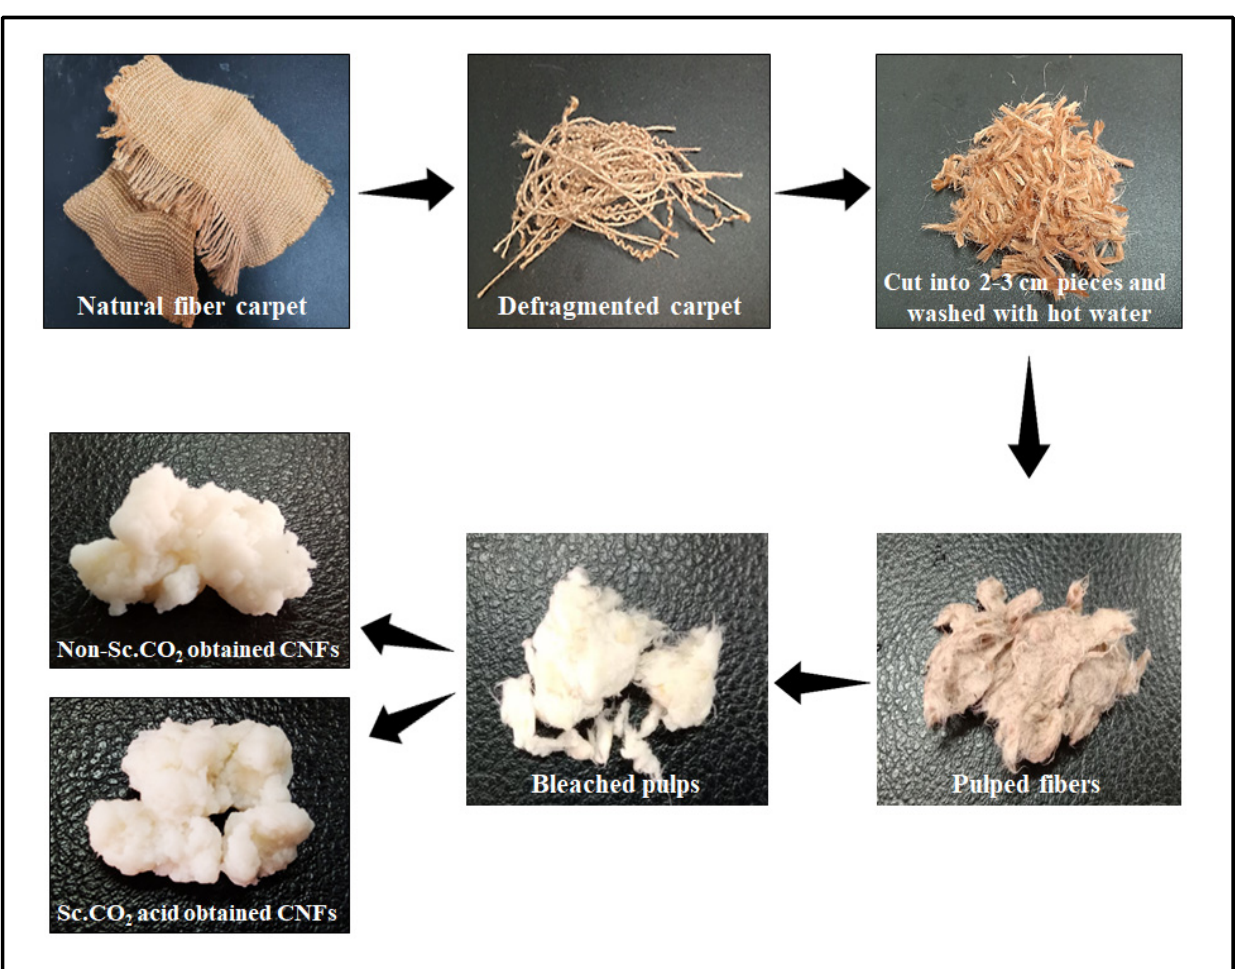
Figure 1. The overall process of preparing cellulose nano fibers (CNFs) from natural fiber carpet